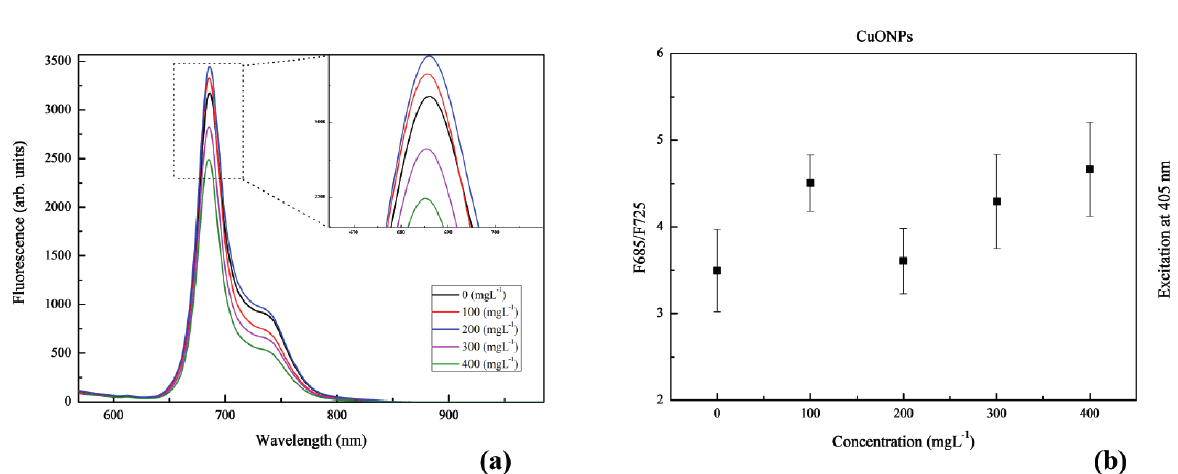
Figure 5. ( a) Fluorescence intensity of seeds of S esbania virgata treated with different concentrations of CuONPs, with 405 nm excitation, at 120 h of germination; (b) F685/F735 ratio according to the CuONP concentration, with excitation at 405 nm and 120 h of